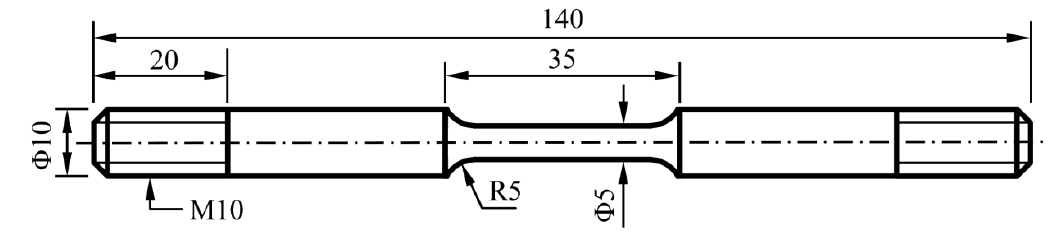
Figure 2. Size of the tensile specimen (unit: mm).